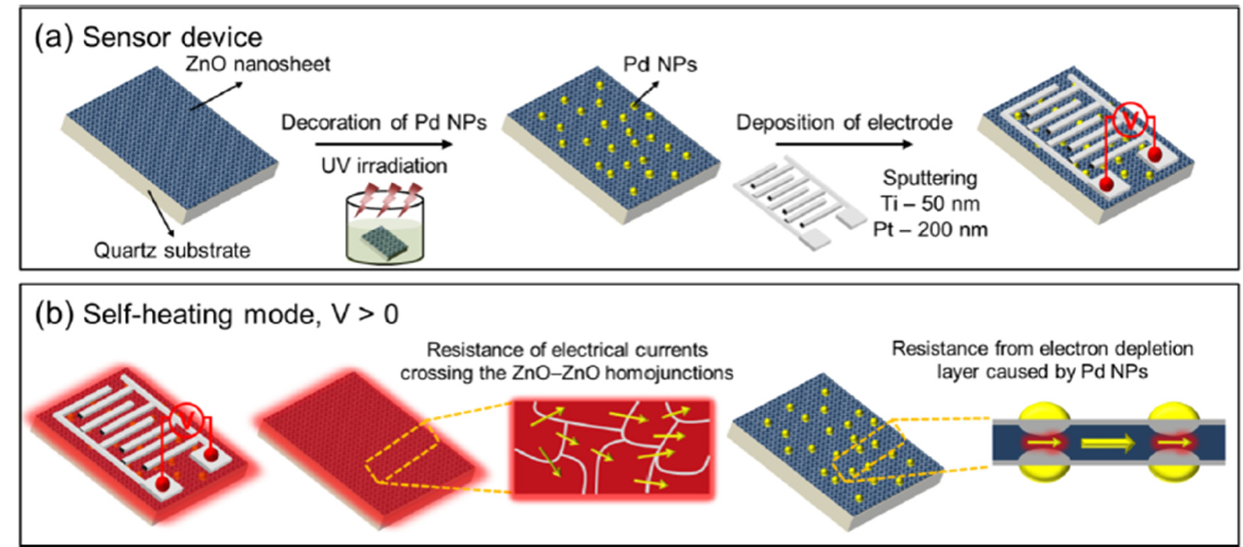
Figure 28. ( a ) Schematic of sensor fabrication and ( b ) operation in self-heating mode [122]. Copyright (2021), with permission from Elsevier.